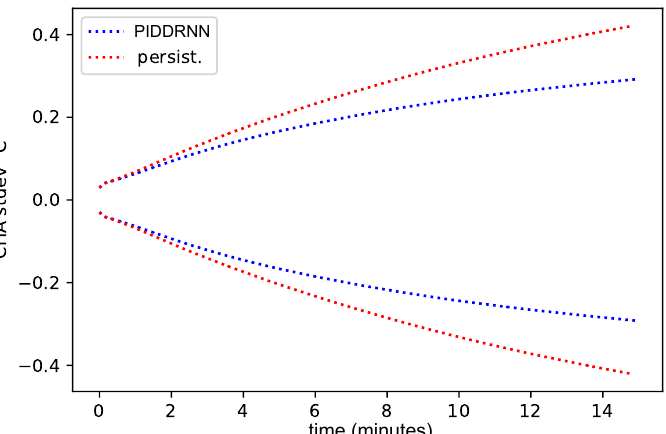
Figure 8. The width of the chamber test set stdev envelopes increases with the prediction horizon without reaching a stable level. The PIDD RNN model performs somewhat better than the persistence reference